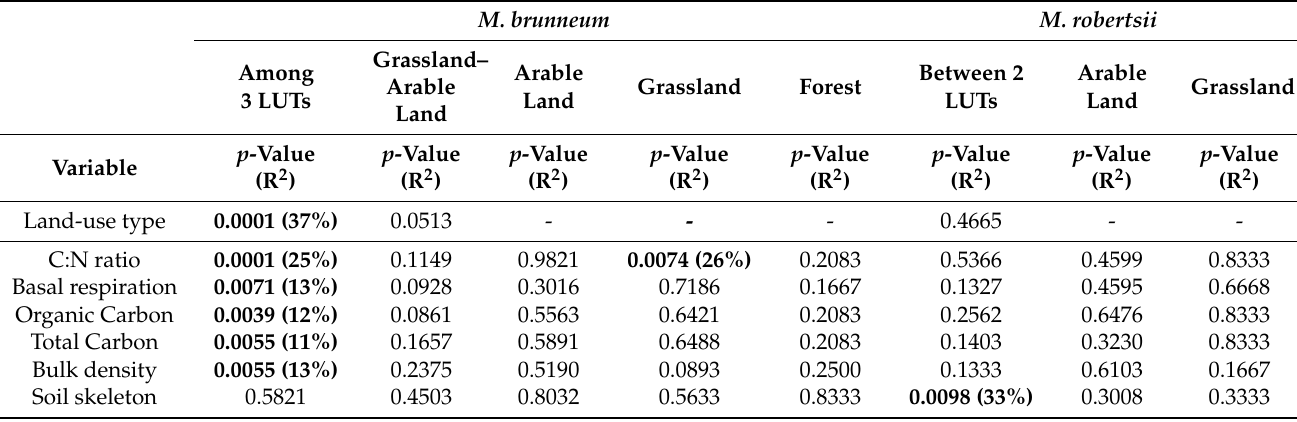
Table 3. Overall permutational multivariate analysis of variance (PERMANOVA) for individual soil and environmental factors, which significantly affect M. brunneum and M. robertsii population structures among and within each land-use type. Analyses were based on Bray–Curtis